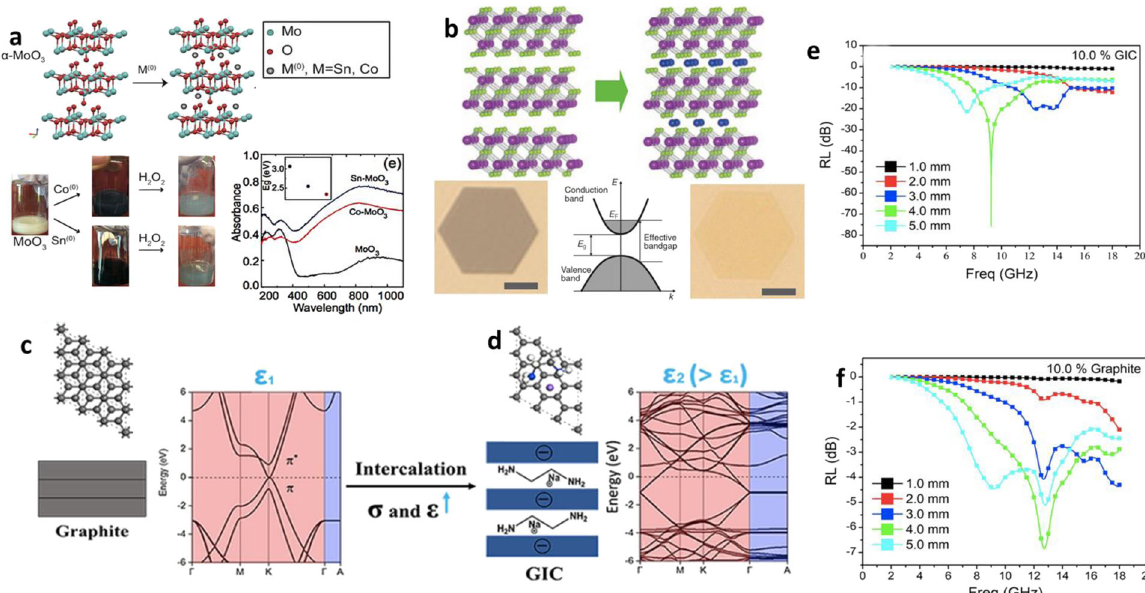
Fig. 5 Intercalation effects on band engineering. a Zerovalent metal intercalation-induced chemochromism in MoO 3 . Schematic illustration of zerovalent metal intercalation into MoO 3 (top). MoO 3 undergoes A color change of MoO 3 dispersed in deionized water when intercalated with Co(0) or Sn(0) metal (bottom-left). UV-visible absorbance of MoO 3 (black line), Co-MoO 3 (red line), and Sn-MoO 3 (blue line) (bottom-right). The band gap is shown as an inset 57 . b The Burstein – Moss (BM) effect in Cu-intercalated Bi 2 Se 3 . Schematic illustration of Cu intercalation into Bi 2 Se 3 (top). Optical transmission image of an 8-nm thick Bi 2 Se 3 nanoplate before (bottom-left) and after (bottom-right) Cu intercalation. Schematic showing the BM shift induced by the increased free electron density (bottom-center) 161 . c , d Sodium-ethylenediamine GIC